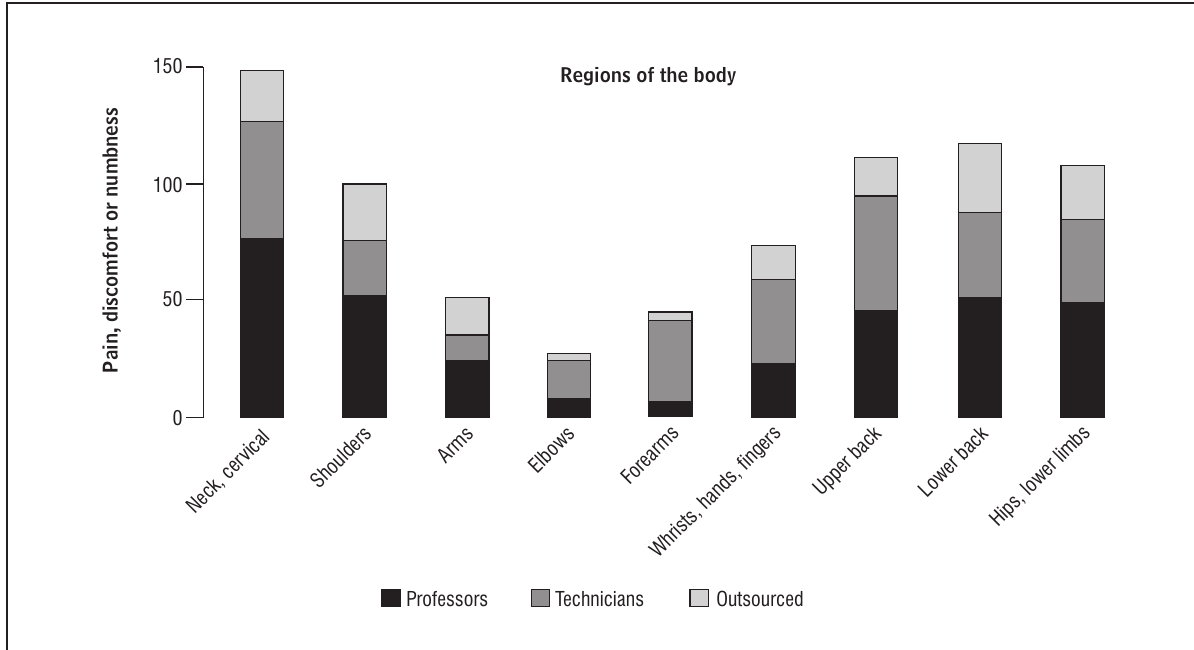
Figure 2 - Regions most affected by pain, discomfort or numbness among Unifal-MG staff (Campus I, Alfenas, Minas Gerais, Brazil)